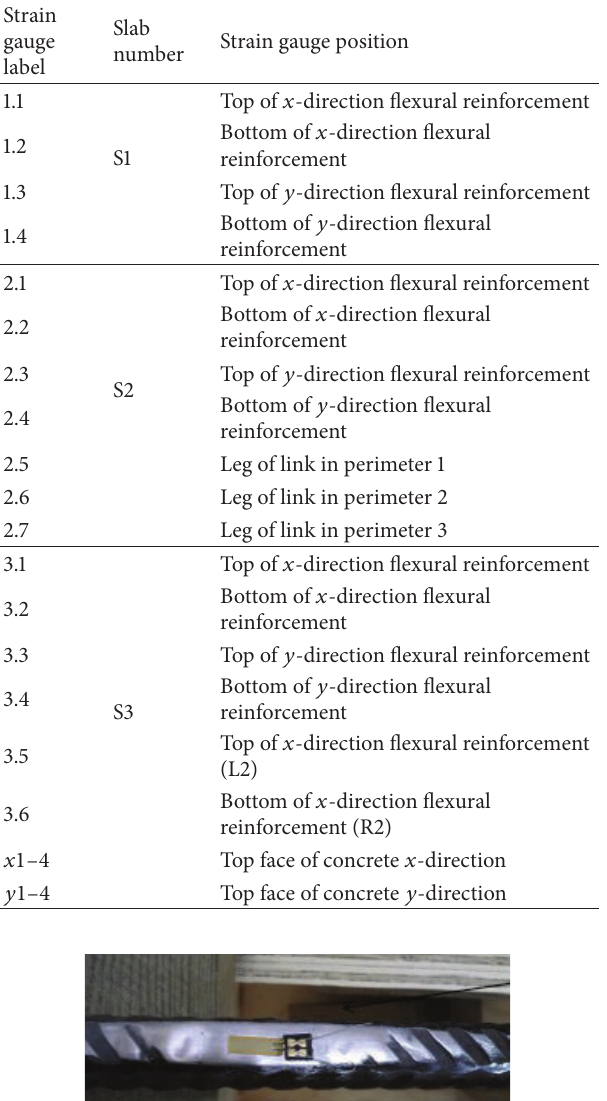
Table 2: Steel strain gauge label and position.